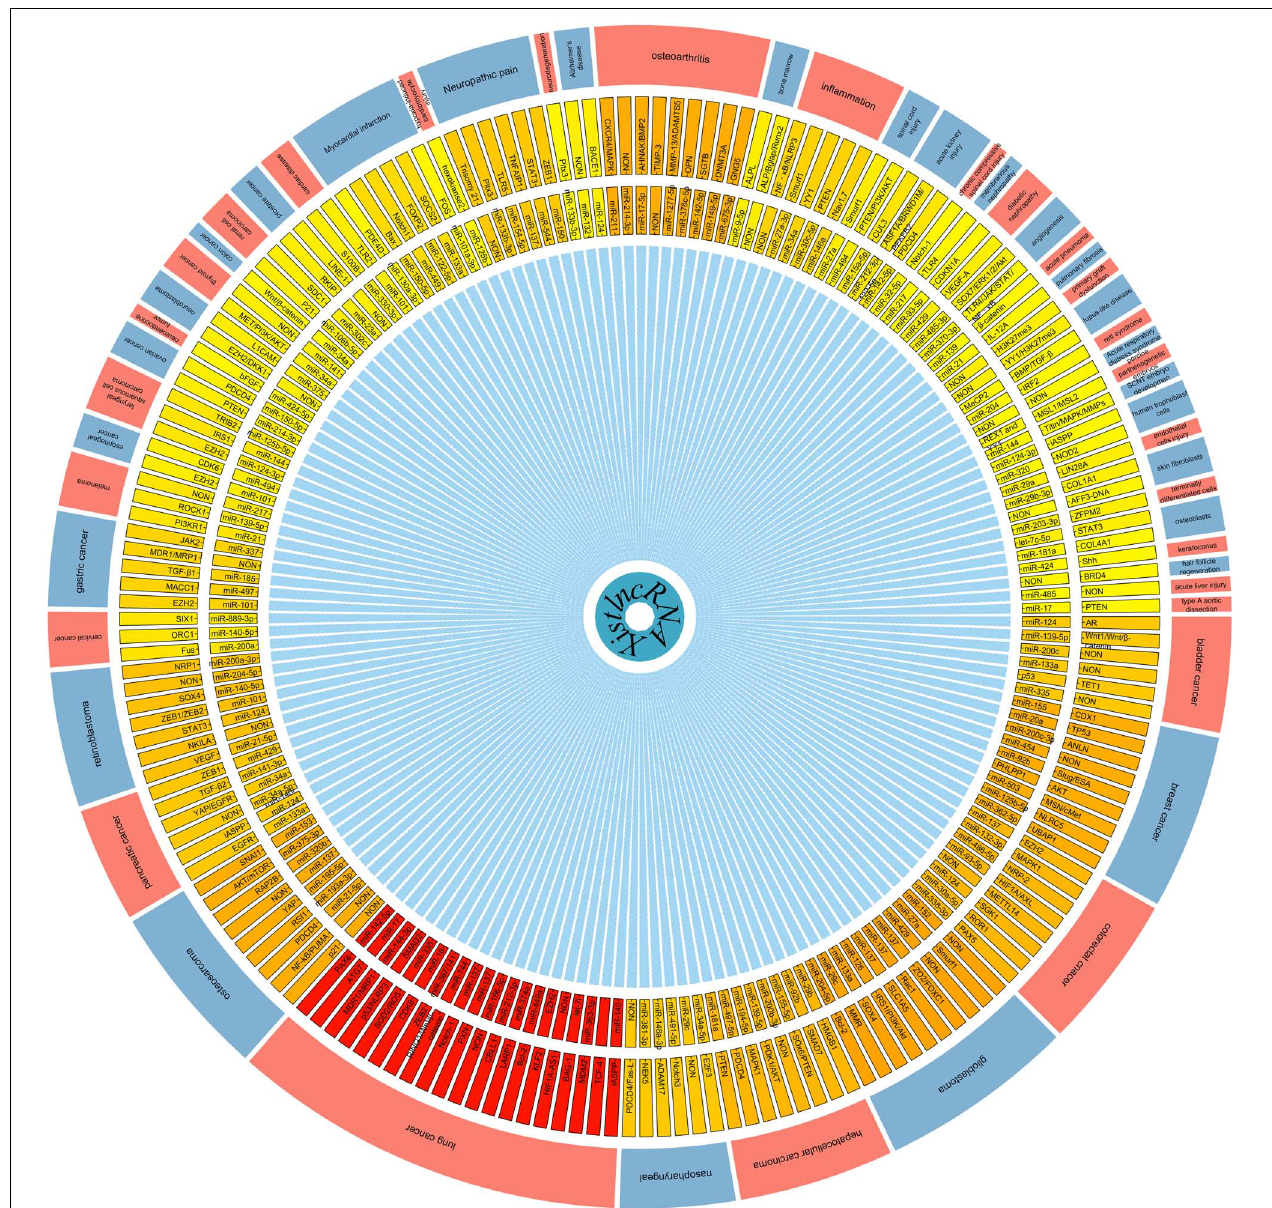
FIGURE 3 | Overview of the regulatory network of lncRNA Xist involved in mammalian diseases and cells. NON, The downstream target